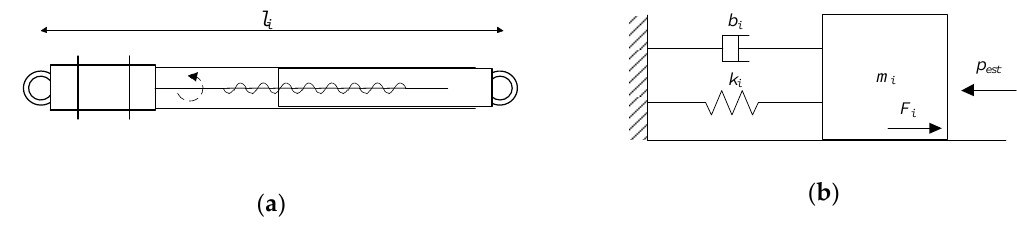
Figure 4. Actuator models. ( a ) Actuator scheme, ( b ) actuator mechanical model.